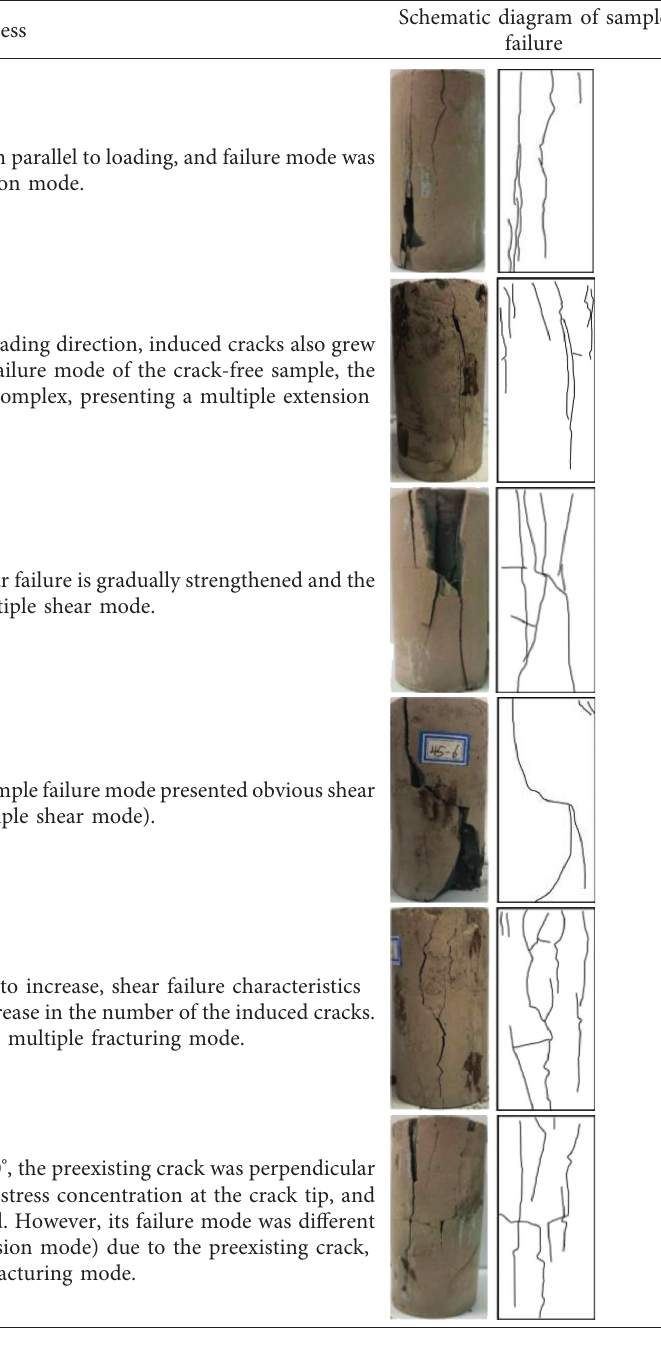
Figure 9. It can be found that the stress concentration